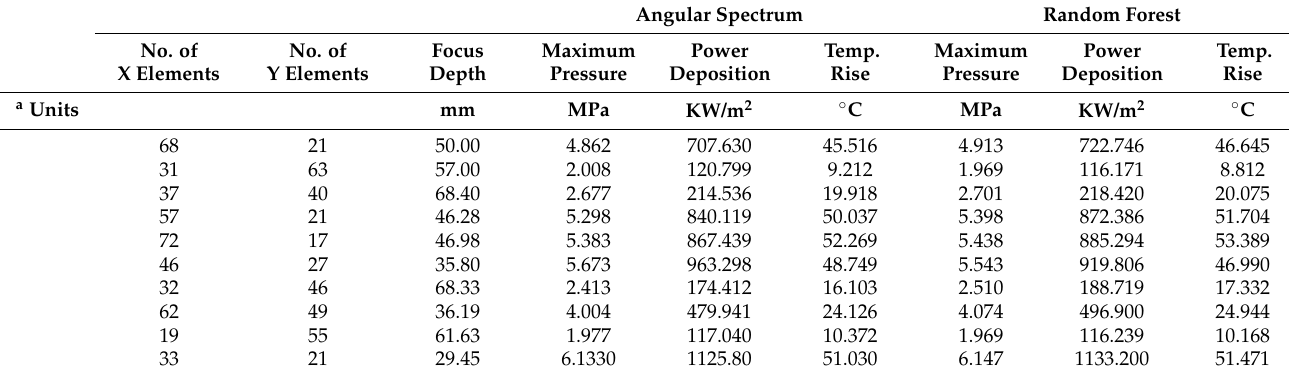
Table A2. Comparison of random forest model with angular spectrum method at 10 random and external data points.